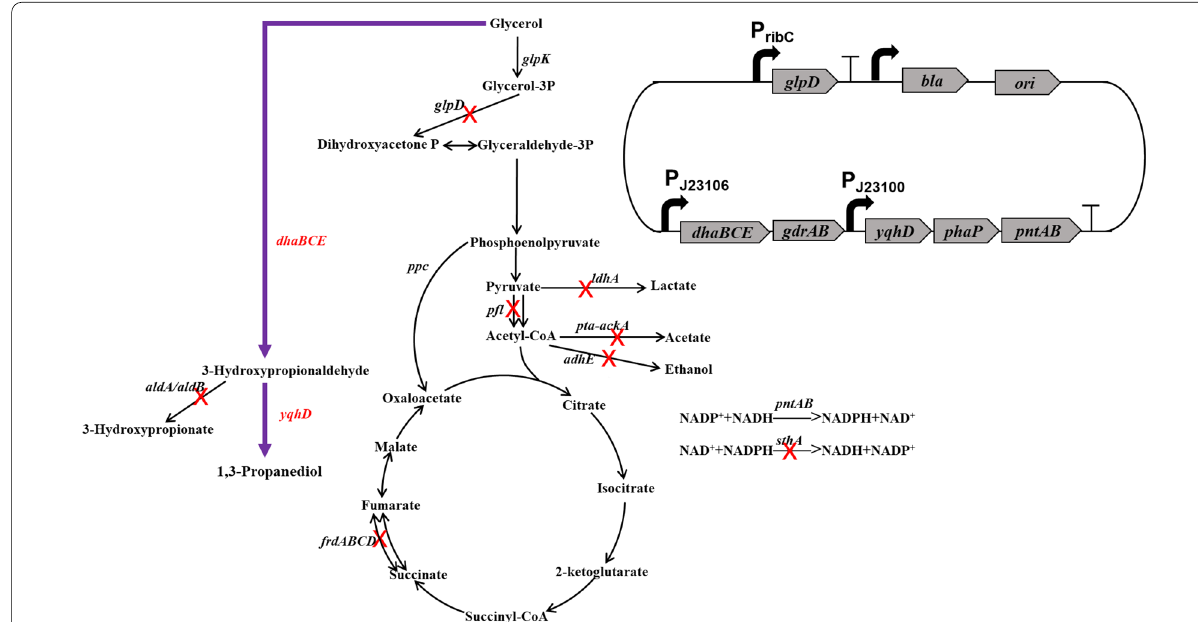
Fig. 1 Metabolic engineering strategies for developing V. natriegens to produce 1,3-PDO. The deleted genes are shown with cross marks. A heterologous 1,3-PDO synthesis pathway is introduced by overexpressing genes encoding glycerol dehydratase ( dhaBCE ) and its activator ( gdrAB ) and a NADPH-dependent alcohol dehydrogenase ( yqhD ). A plasmid stabilization system is developed by deleting the chromosomal glpD gene encoding glycerol-3-phosphate dehydrogenase and expressing the corresponding gene in the expression